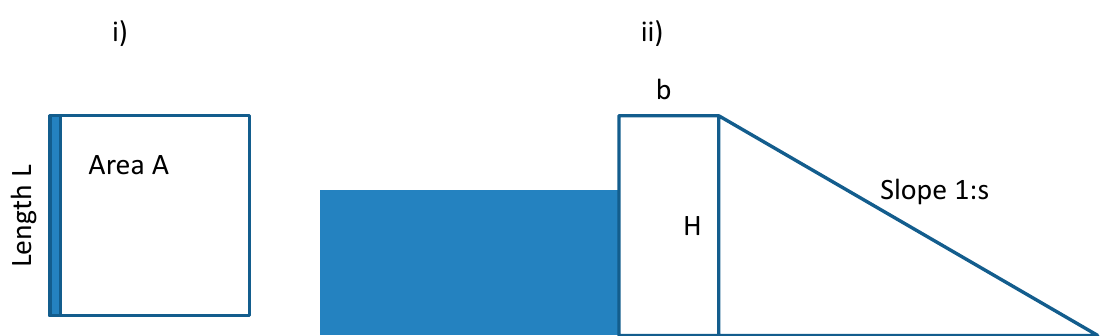
Figure 1. Schematic for river in flood plain and dam: i) The river runs along the side of a square representing the flood plain with area A . ii) Dam geometry with crest b, height H and slope 1: s .